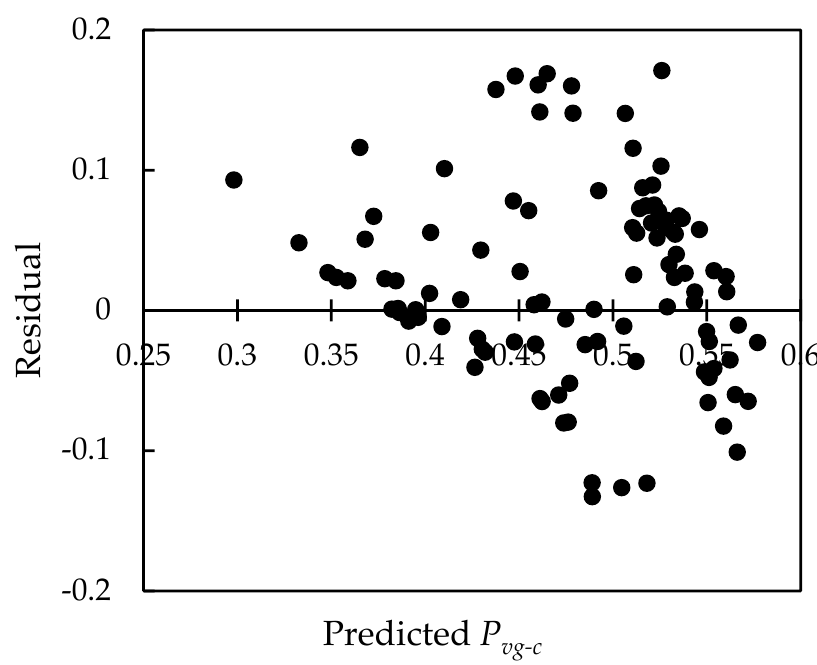
Figure 10. The residual plot of the estimated P vg-c and n × d 2 .